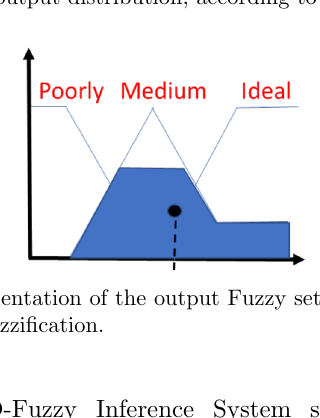
Fig. 3. Representation of two Fuzzy inputs sets and their corresponding Fuzzy output distribution, according to the Fuzzy rule.